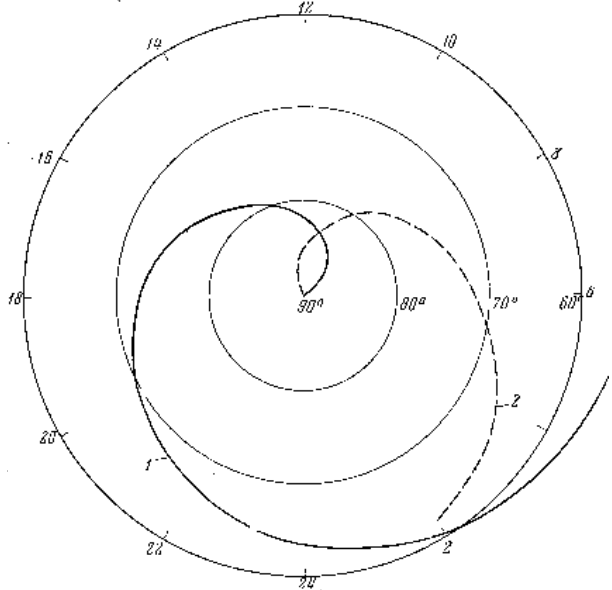
Figure 9. Dependence of occurrence times of MLT “night” and “morning” maxima in diurnal changes of probability of auroras appearance in zenith on geomagnetic latitude in polar coordinates (Feldstein, 1960). 1 – night maximum; 2 – morning maximum.